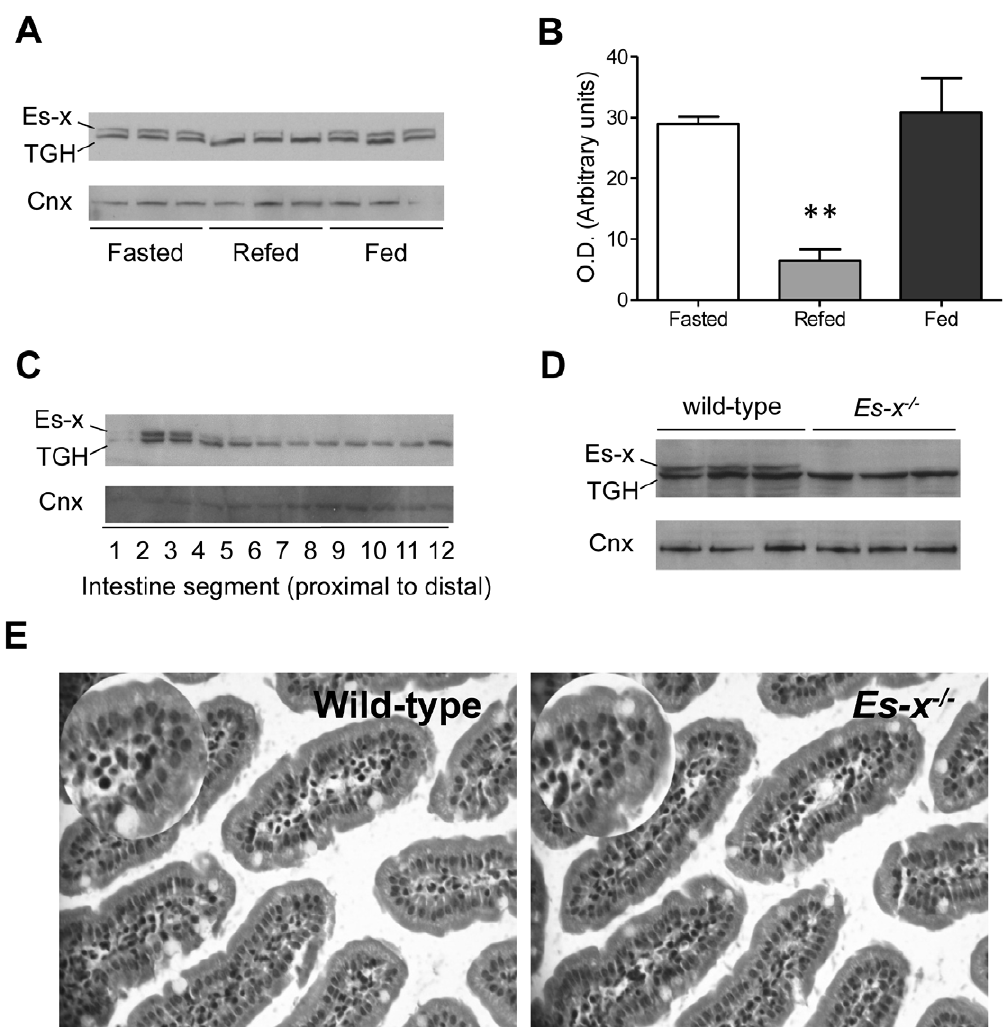
Figure 1. Intestinal Ces1/Es-x expression is regulated by nutritional status. (A) Intestinal Ces1/Es-x protein expression in different nutritional states. Mice were fasted for 24 h and refed for 6 h. Fasted and refed mice were euthanized at 8:00 P.M. TGH is a related carboxylesterase migrating at a lower M r due to lesser glycosylation and is recognized by the polyclonal anti-Ces1/Es-x antibodies. Two m g intestinal proteins were subjected to analysis. Cnx, calnexin = loading control. (B) Quantitation of Ces1/Es-x immunoreactive bands obtained in different nutritional states. **p , 0.01 Refed vs Fasted. (C) Ces1/Es-x protein distribution along the small intestine. Small intestine was cut into 12 pieces 2-cm long. Proteins were separated by SDS-PAGE and immunodetected with anti-Ces1/Es-x antibodies. Representative data from 3 different independent experiments are shown. (D) Absence of Ces1/Es-x protein (immunoblot) in the intestine from Ces1/Es-x 2 / 2 mice. (E) H&E staining of small intestine (200 6 ) sections. doi:10.1371/journal.pone.0049515.g001 2 mice secreted significantly more radioactivity incorporated into plasma TG compared to wild-type, indicative of increased secretion of chylomicron-associated TG (Figure 3E). To further investigate intestinal apoB secretion, chylomicrons were collected from lymph and apoB composition was determined by immuno- blotting. As shown in Figure 3F, chylomicrons (apoB48) were present in the lymph of Ces1/Es-x 2 / 2 mice even in the absence of secretion stimuli (time 0). This increment in apoB48 secretion in Ces1/Es-x 2 / 2 mice was sustained up to 4 h after olive oil stimulus. These results are in line with hyperlipidemia observed in fasting Ces1/Es-x 2 / 2 mice [3].